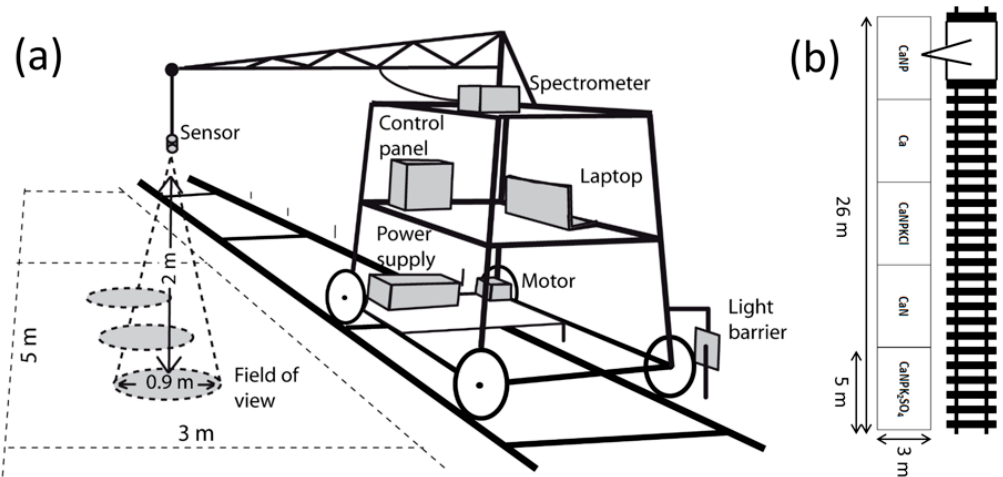
Figure 1. Setup of the automated field observation system with its components ( a ) and arrangement of fertilizer treatments and monitoring plots ( b ).